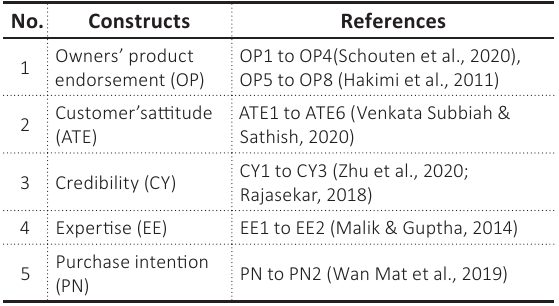
Table 1. Framework of